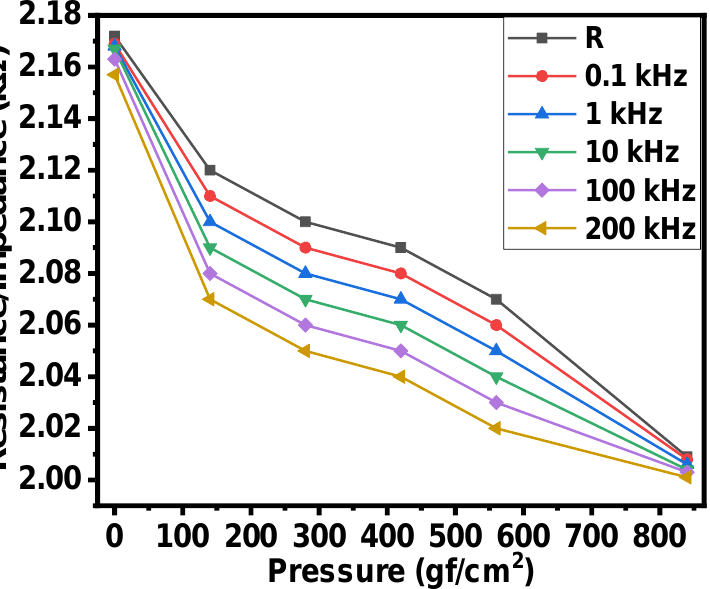
Figure 4. Resistance/impedances-pressure relationships of the surface type shockproof resistor based on NiPc – oil jelly and CNT – oil jelly rubber composite. Similarly, when increasing the humidity from 59% to 90% RH (relative humidity), the resistance and impedance of the samples decreased by up to 1.04 times. The re- sistance/impedance – humidity relationships are shown in Figure 5. The R-squared (R 2 ) values for the resistance – humidity and impedance – humidity relationships were also cal- culated. The value of R 2 for the resistance – humidity relationship was 0.865, while for the impedance – humidity relationship, these values were in the range of 0.967 to 0.991. Figure 5. Resistance/impedance – humidity relationships of the surface-type shockproof resistor based on NiPc – oil jelly and CNT – oil jelly – rubber composite.